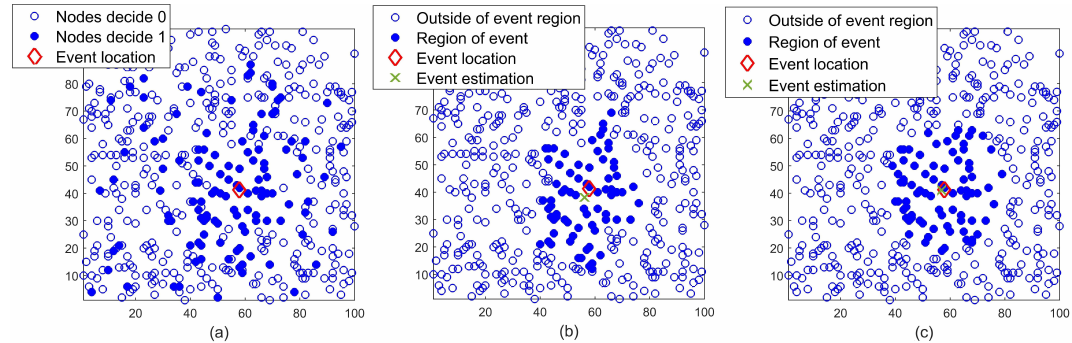
Figure 4. ( a ) Distributed detection in a wireless sensor network with 500 nodes randomly deployed in a 100 m × 100 m region and local false alarm probability p fa = 0.1. ( b ) Event localization after applying Red-S. ( c ) Event localization after applying